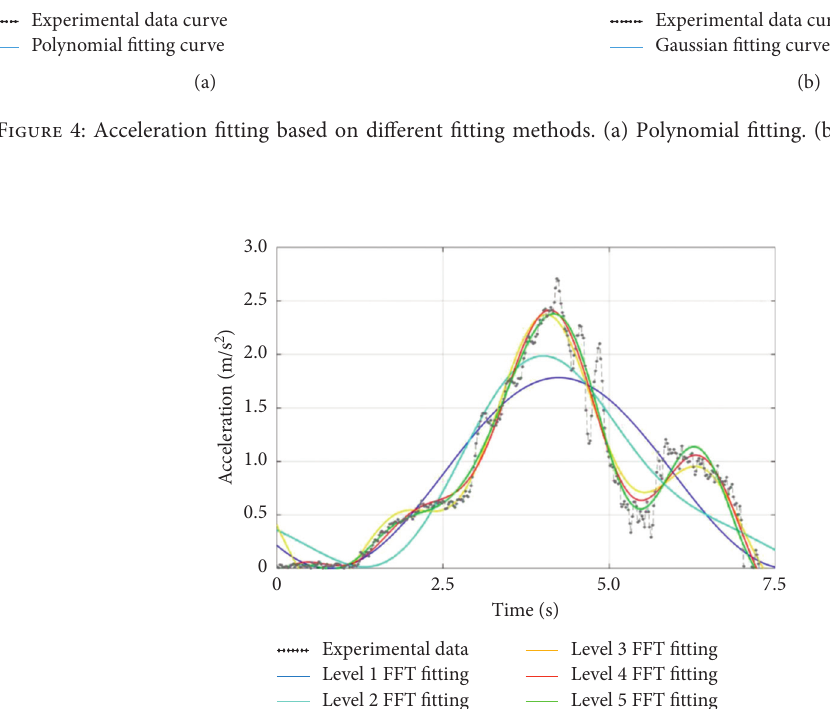
Figure 5: Acceleration fitting based on multiple FFT method.